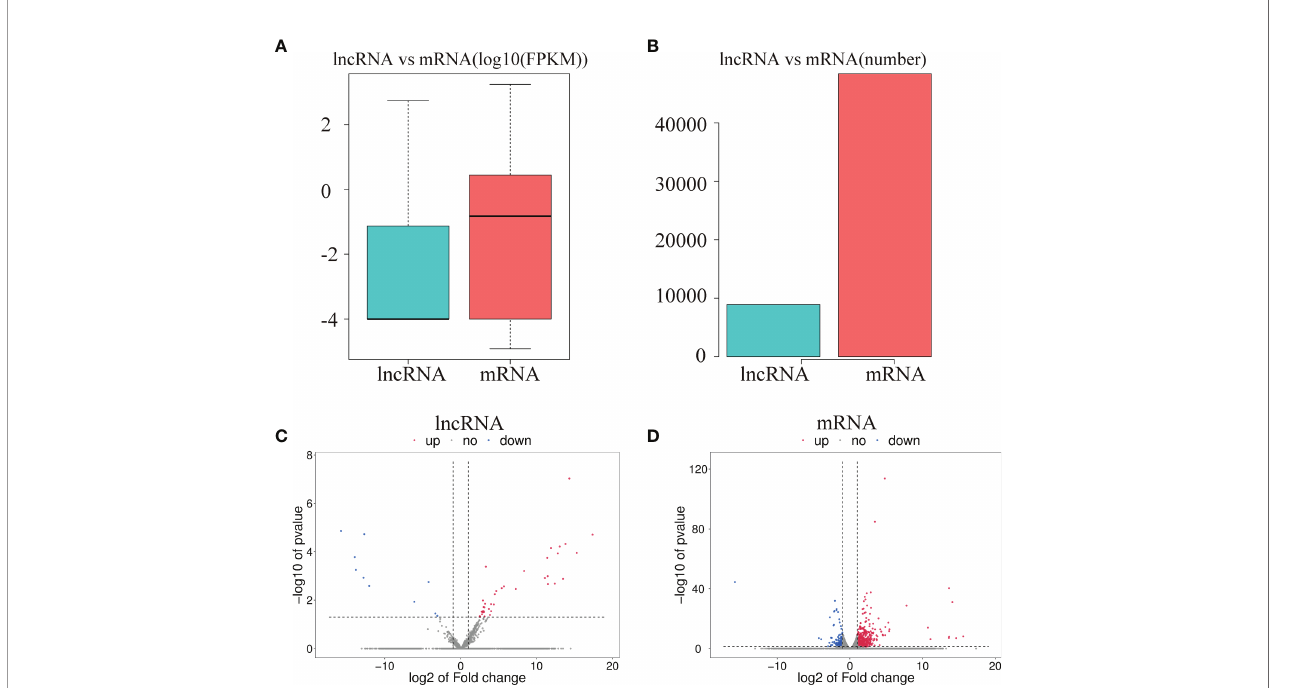
FIGURE 4 | The differential expression of lncRNAs and mRNAs. (A) The signi fi cantly differentially expressed lncRNAs and mRNAs between the CPB2 group and the control group (using the log10 FPKM method) box plots. (B) The number of signi fi cantly differentially expressed lncRNAs and mRNAs. (C) The differentially expressed lncRNAs in the control group and CPB2 group. (D) The differentially expression of mRNAs in the control group and the CPB2 group. Blue indicates a signi fi cant increase, and red indicates a signi fi cant